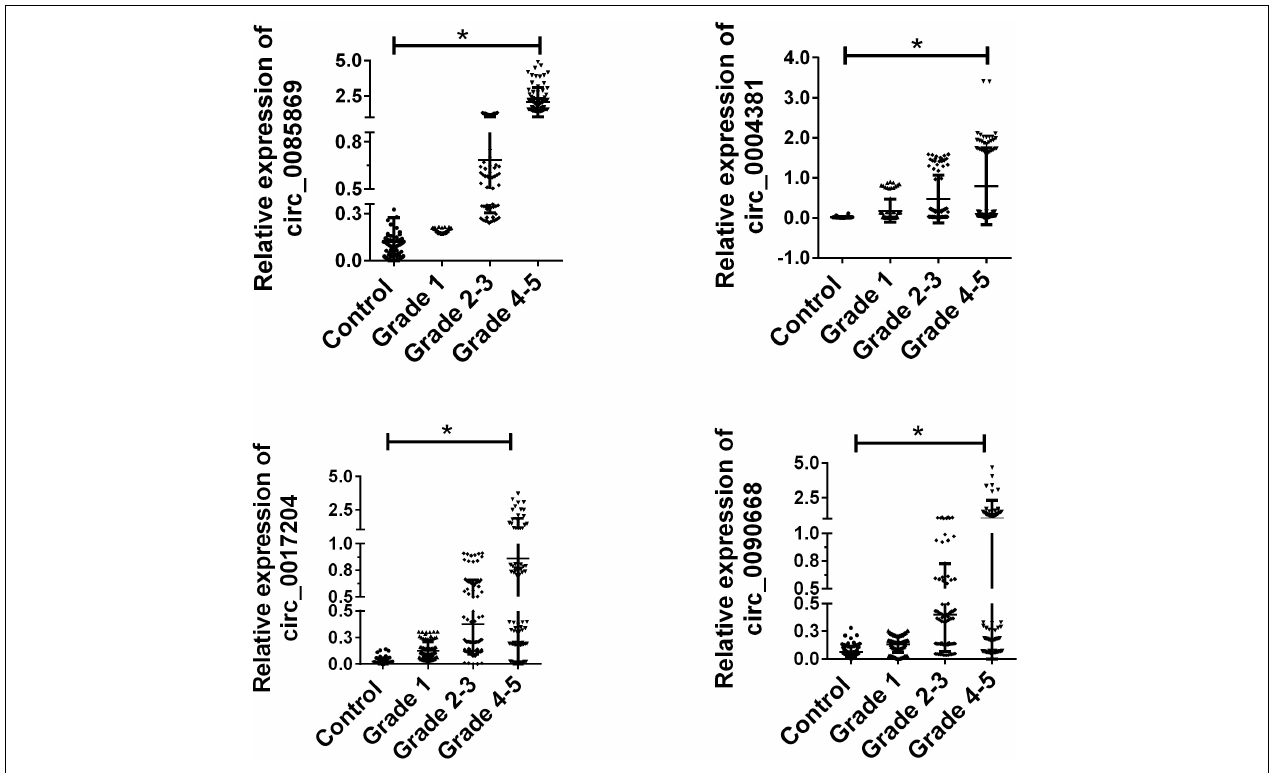
FIGURE 3 | Validation of candidate circRNA in validation set. Total 80 paired plasma from PD patients with different stages, and 80 healthy controls were used in RT-qPCR analysis. Data was presented as mean ± SEM. Data was analyzed with student t -test, * indicated p < 0.05.